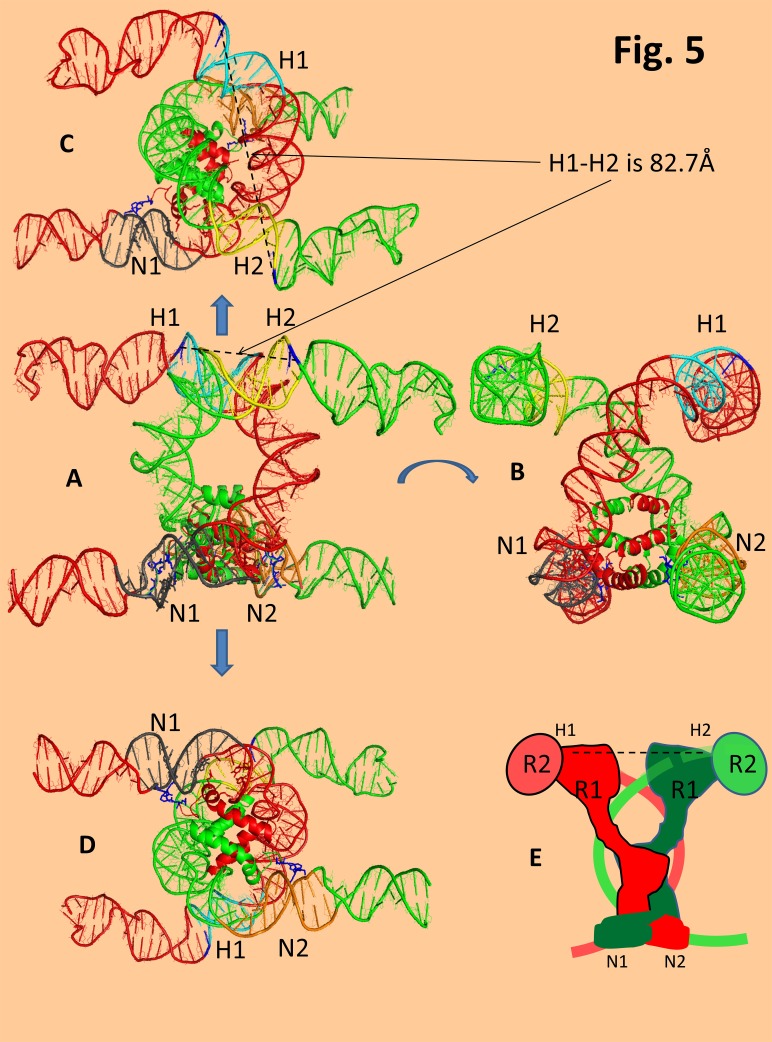
Model of the two bent 23-RSSs configured in the RAG PC, according to the FRET experimental constraints55.The model was realized by docking the dimeric NBD 389-464 aa. domain of RAG1 reported in5) (PDB code - 3GNA.pdb) onto the nonamer of the modeled PC bent 23-RSS. For docking the following constraints were respected: the O2 of the Thymidine [DT 79] and the O2 of Thymidine [DT 80] are contacted byArg391 NH2 side chain and the main Amide chain. The O6 of the guanine residue from the 23-RSS[DG 83] is also directly contacted by an Arg 402. In the 23-RSS, besides these Base-aa. direct contacts there are hydrogen bridges with the following phosphates: The phosphate of thymidine residue[DT 45] (with theNH2- of Lys405), and the phosphate of the cytidine [DC 44] (with the NH2- of Lys412). A- front view, B- side view 90 rotated, C-upper view , D-bottom view. The H1-H2 , measures the inter heptamer distance of the two 23-RSSs from the 5' phosphates of the 5' dC at heptamer coding flank junction(colored in navy blue). RSS1 in red has the Nonamer N1 colored in grey, and the heptamer H1 in light blue. Green RSS2 has the Nonamer colored in orange N2 and the heptamer H2 in yellow. E-cartoon representation of the best way to fit the SEC RAG protein organization modeled by Grundy et.al. 200950, to our 2 RSS model. The peptidic AT-hook-like GGRPR motif of NBD is colored in navy blue.